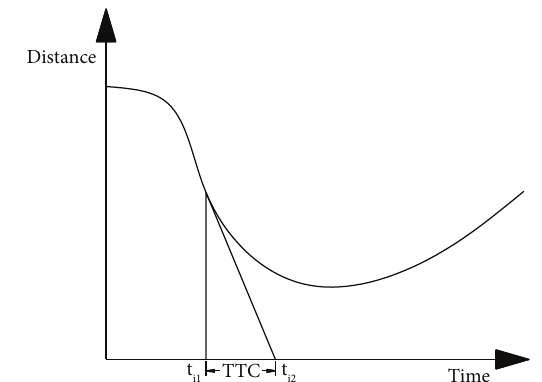
Figure 2: Schematic diagram of TTC calculation for rear-end conflict.